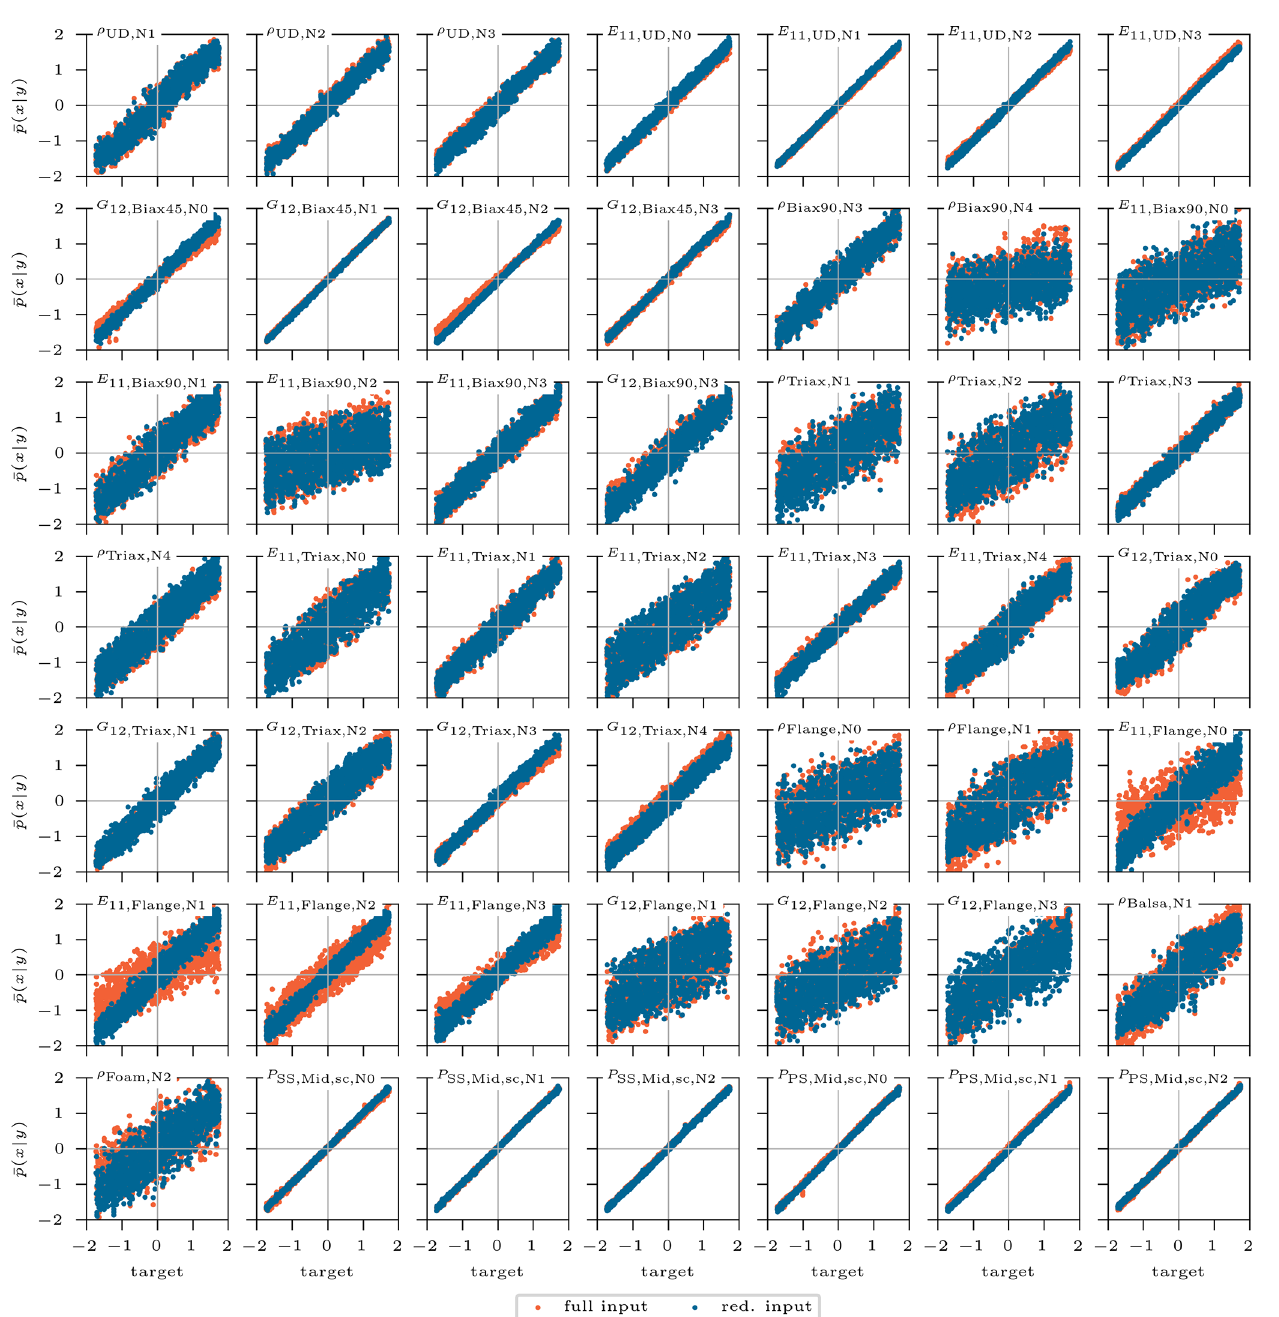
Figure A2. Standardized mean of posterior prediction x of the inputs selected by the sensitivity analysis, over the corresponding target standardized values for the 5000 test samples. The original samples predicted with the reduced input set according to the sensitivity analysis selection are depicted in blue. They are compared with the inputs predicted by the cINN trained on the full input set (in orange).